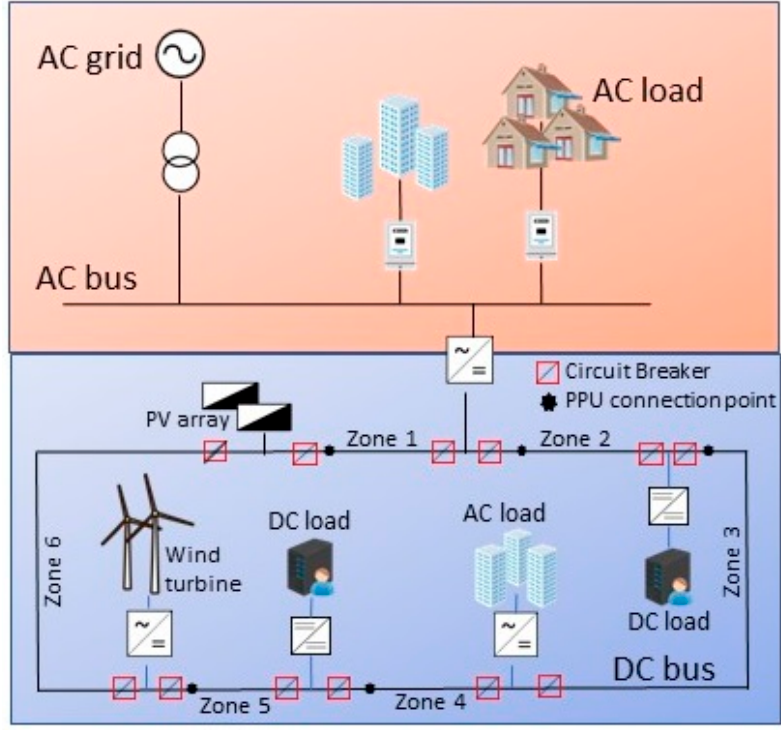
Figure 13. Schematic diagram of low-voltage DCMG with PPU units [124].